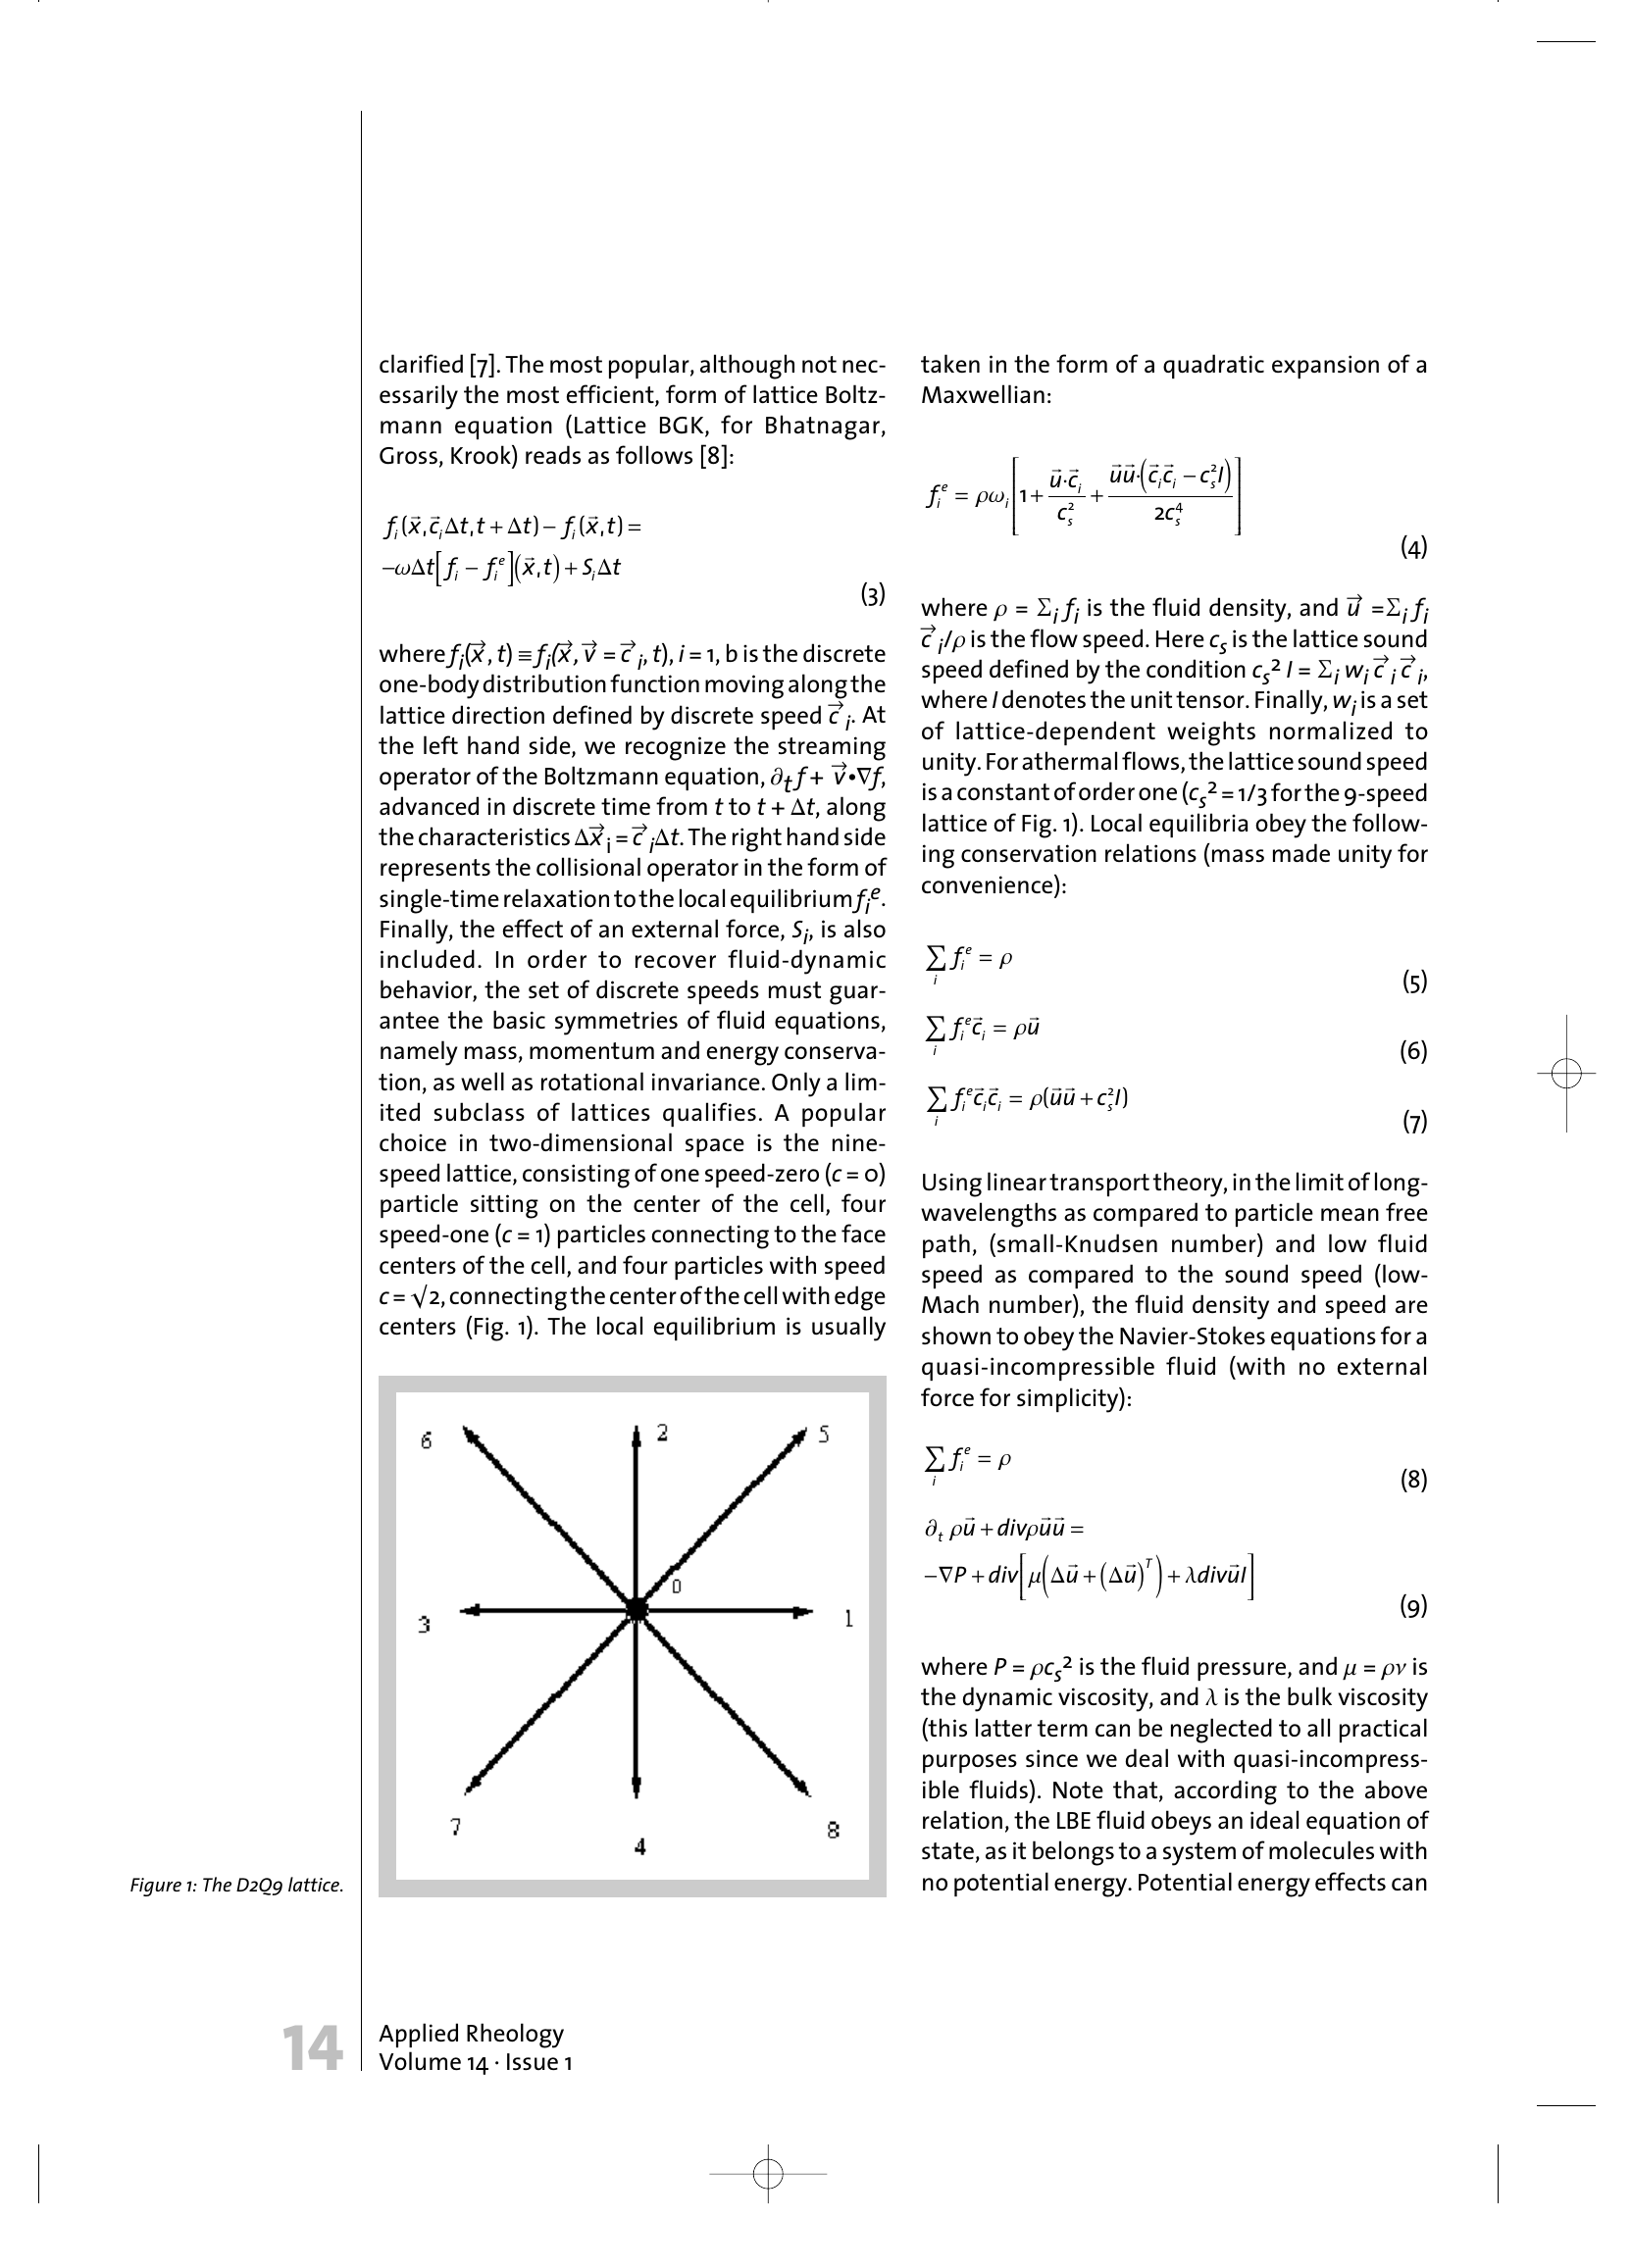
Figure 1: The D2Q9